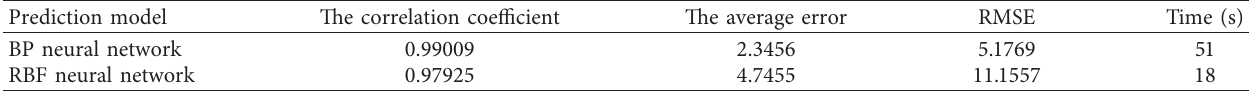
Figure 9: The prediction correlation relationship of RBF neural network Table 2: The preference comparison between BP and RBF neural network.